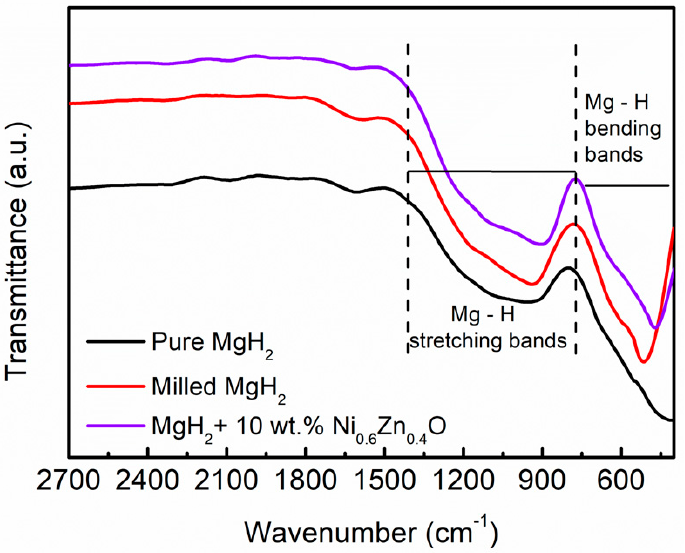
Figure 9. FTIR pattern of ( a ) pure MgH 2 , ( b ) milled MgH 2 and ( c ) MgH 2 –10 wt.% Ni 0.6 Zn 0.4 O samples. The XRD pattern of the MgH 2 –10 wt.% Ni 0.6 Zn 0.4 O samples after milling for 1